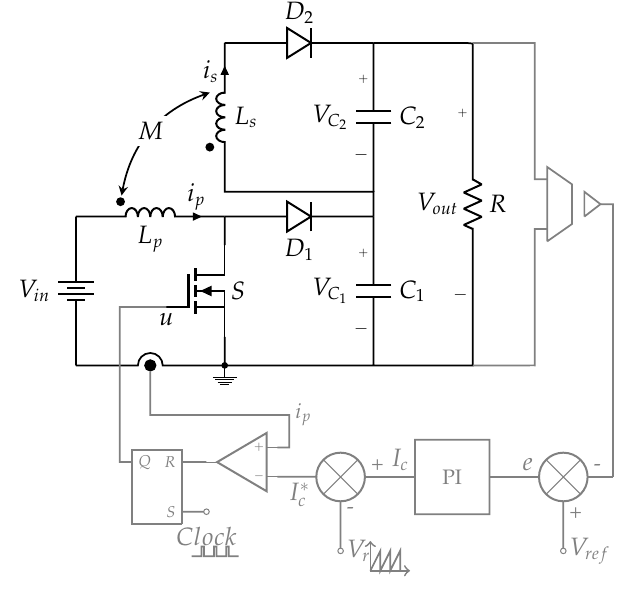
Figure 1. Boost-flyback converter with peak current-mode